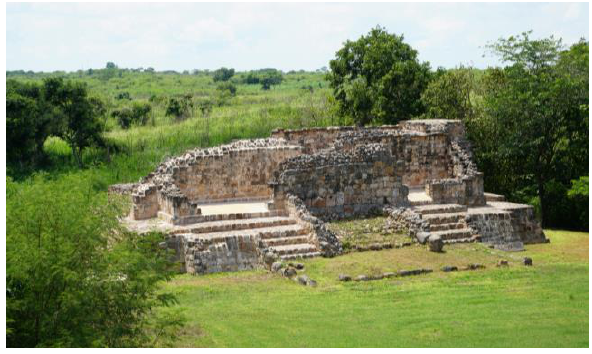
Figure 2. Satunsat (Structure 3B1), South Plaza (D.